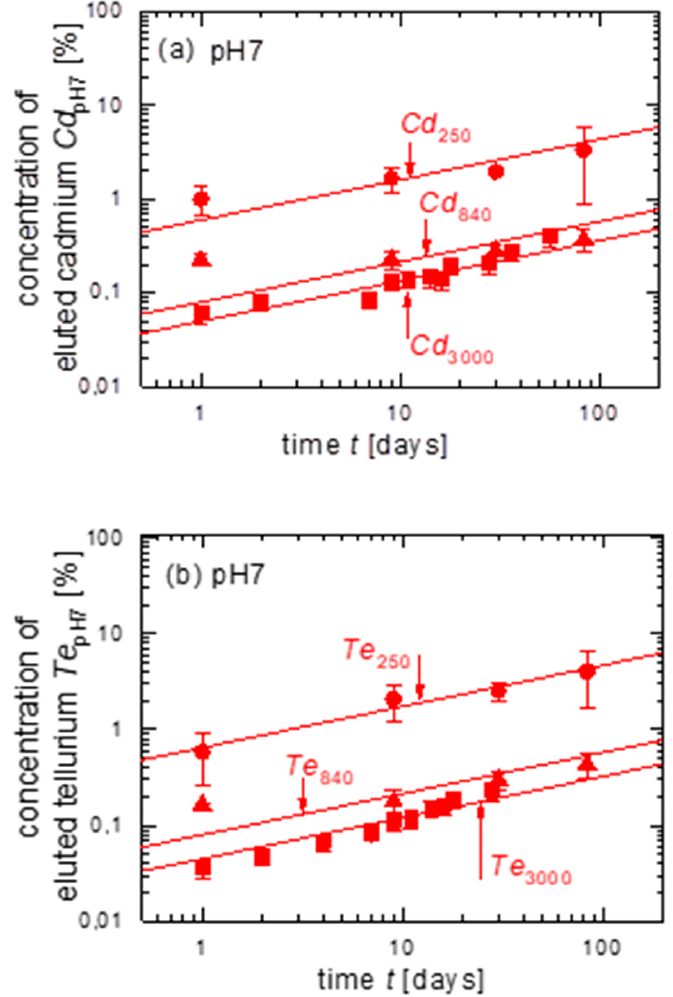
Figure 4. Elution of Cd pH7 and Te pH7 in solutions with pH7 out of CdTe powder. Compared to Figure 2, the absolute values for eluted Cd and Te are lower. However, we observe the same time dependence Cd pH7 ~ t 0.43 and Te Ph7 ~ t 0.43 . ( a ) The elution of Cd for the CdTe-powder with the smallest grain diameter is the highest, it holds Cd 250 > Cd 840 ≈ Cd 3000 . The elution out of Cd 840 and Cd 3000 show only small differences. ( b ) Also for Te it holds Te 250 > Te 840 ≈ Te 3000 . Elution values from milled CdTe-modules are not available for pH7.